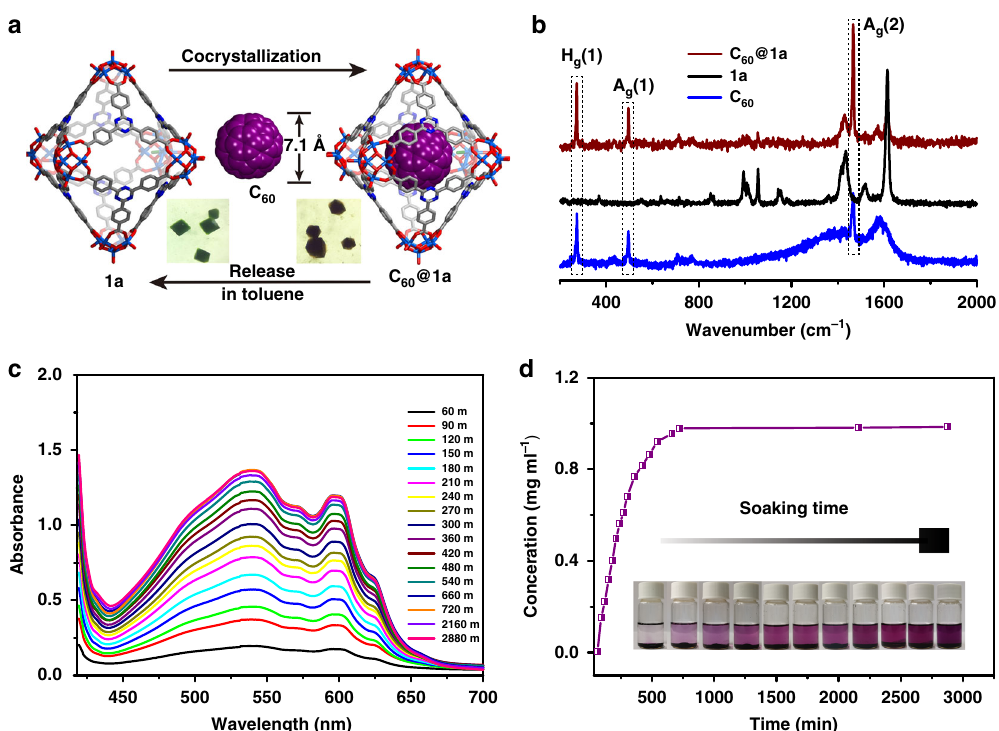
Fig. 5 The inclusion and release of C 60 molecules in 1a. a A schematic illustration of the inclusion and release of C 60 molecules in 1a . b Raman spectra of C 60 , 1a and C 60 @1a . c Temporal evolution of UV – Vis absorption spectra of C 60 in toluene solution. d Concentration changes of C 60 in toluene solution with time. The inset fi gure shows the color evolution of the toluene solution with time.